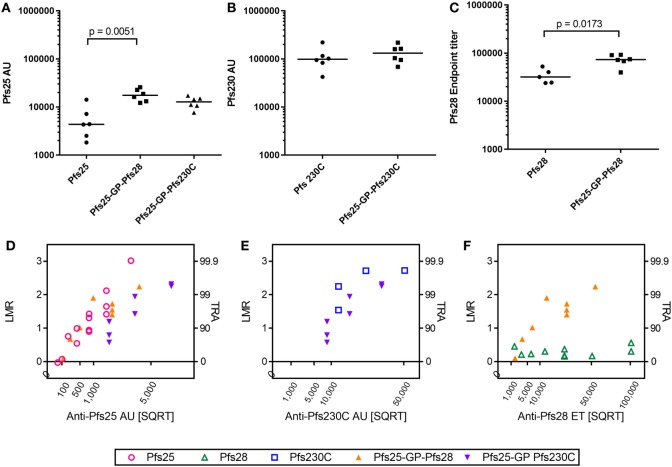
Immunogenicity and transmission reducing ability in standard membrane-feeding assay (SMFA) induced by vaccination with chimpanzee adenovirus 63 (ChAd63)–modified Vaccinia Ankara (MVA) expressing single- or dual-antigen vectors in mice. Day 70 antigen-specific IgG responses in mice after immunization with ChAd63-MVA expressing single antigens (Pfs25, Pfs230C, and Pfs28) and dual-antigen antigens linked with glycine–proline (experiment 5, n = 6/group). The figure shows the total IgG response against Pfs25 (A), Pfs230C (B), and Pfs28 (C). Response was measured by standardized ELISA (A,B), expressed in antibody units (AUs) and endpoint ELISA (C) expressed as Pfs28 endpoint titer. Median and individual data points are shown. Either a Kruskal–Wallis test followed by Dunn’s tests [(A)
p = 0.0023 by a Kruskal–Wallis test, p values by Dunn’s tests are shown] or Mann–Whitney tests (B,C) were performed. Total IgG was purified from the pooled day 70 mouse serum, and each IgG was tested at three to seven different total IgG concentrations in two to five independent SMFA assays (Table S3 in Supplementary Material). The square root of antigen-specific antibody concentrations [anti-Pfs25 AU (D), anti-Pfs230C AU (E), or anti-Pfs28 ET (F)] in the feeder is shown on the x-axis. The log-transformed mean oocyst ratio between test and control (LMR) are plotted on left side of y-axis, and the associated % inhibition in oocyst density (transmission-reducing activity) is shown on the right side of the y-axis.